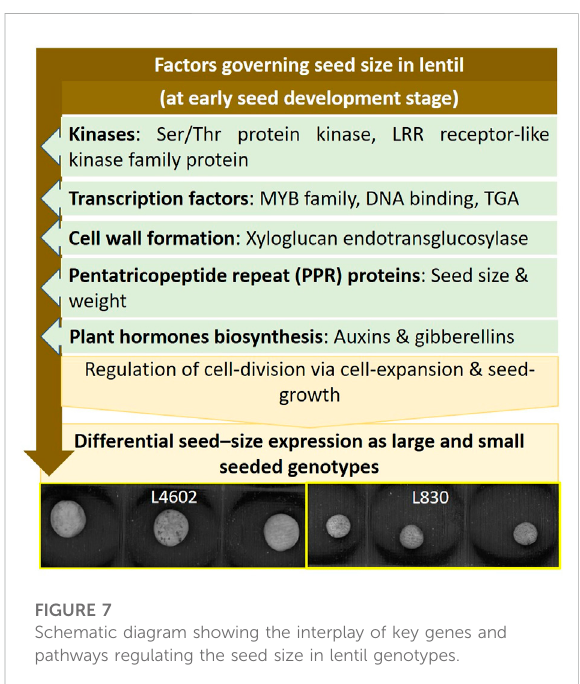
FIGURE 7 Schematic diagram showing the interplay of key genes and pathways regulating the seed size in lentil